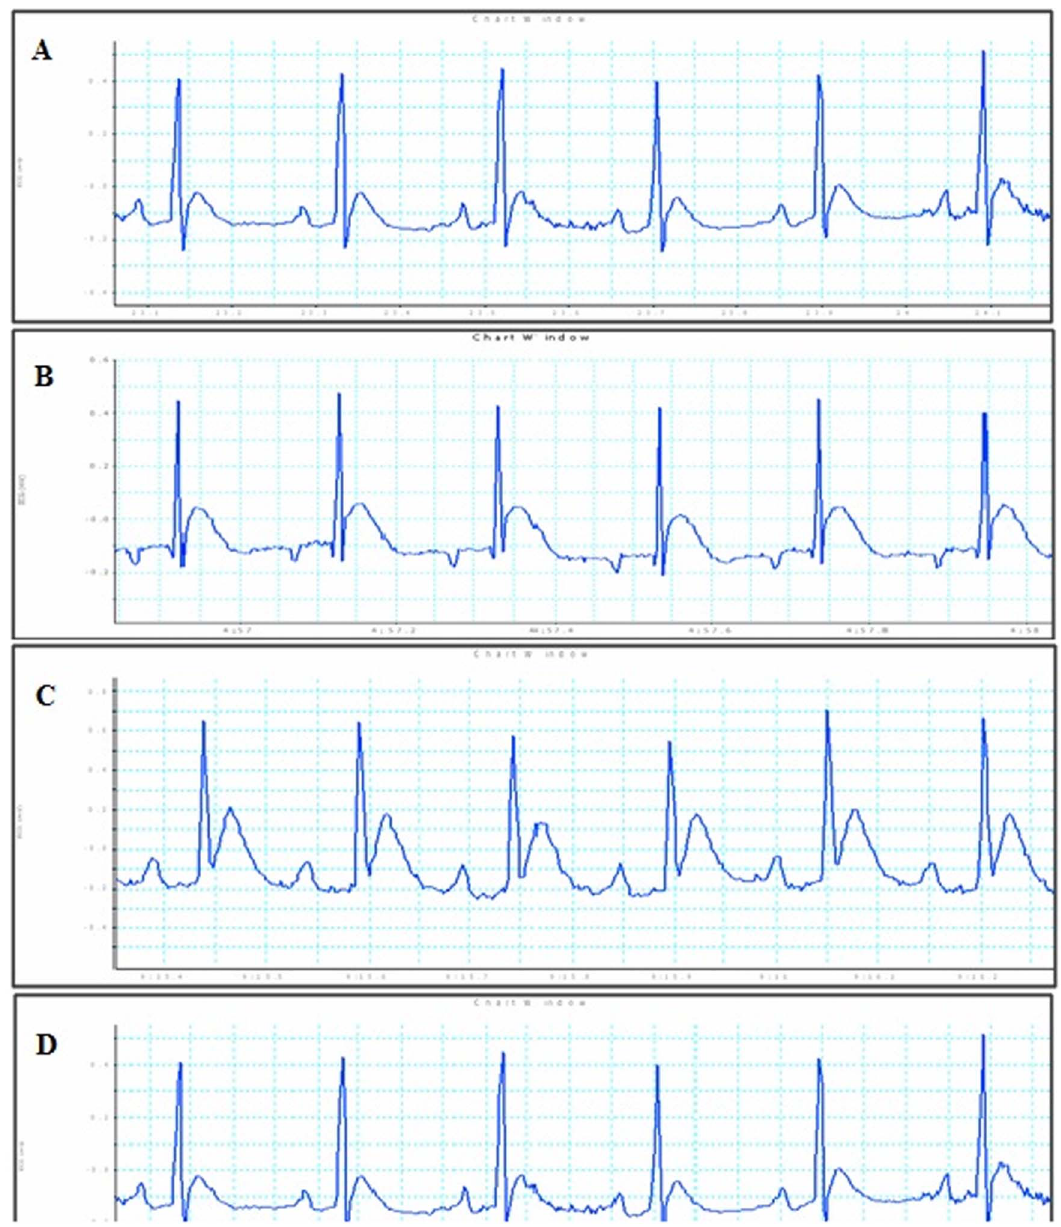
Figure 1. Effect on electrocardiographic parameters. (A) Non-diabetic control, (B) Diabetic control group, (C) L-glutamine (500 mg/kg) and (D) L-glutamine (1000 mg/kg).